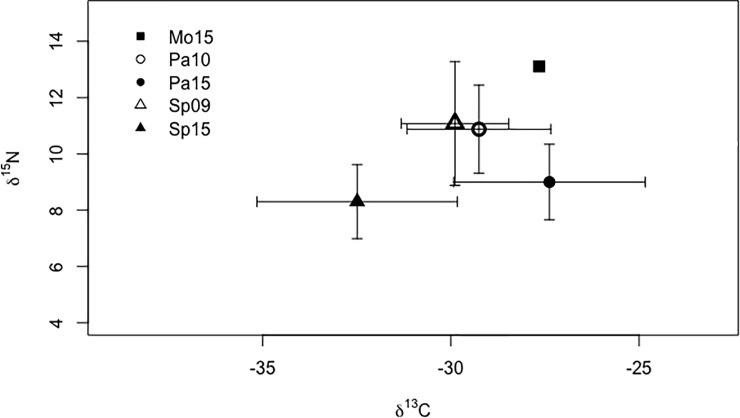
Isotopic values of 𝛿15N and 𝛿13C from Neotropical river otter scats collected from the study area.Error bars are one sd. Mo15 = samples from Mopan River 2015 (n = 1); Pa10, Pa15 = samples from Pasion River 2010 and 2015 (n = 36 in 2010 and 34 in 2015); Sp09, Sp15 = samples from San Pedro River 2009 and 2015 (n = 20 in 2010 and 55 in 2015).